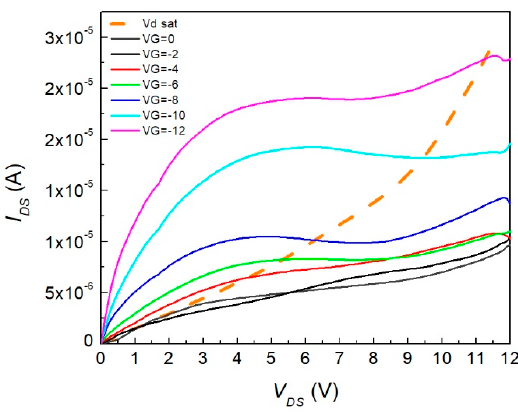
Figure 10. Threshold voltage characterization of the device.